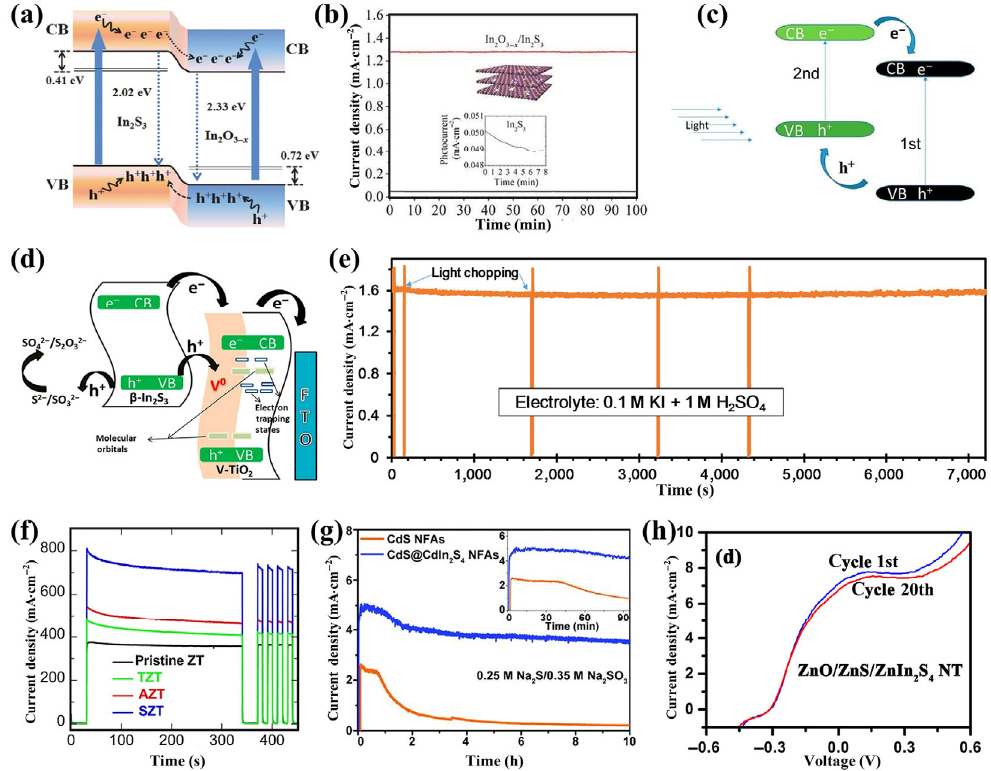
Figure 9 (a) Schematic illustration of the band alignment of the In 2 O 3− x /In 2 S 3 heterostructure. (b) I – T curves of the In 2 S 3 layer and In 2 O 3− x /In 2 S 3 -180s. Reproduced with permission from Ref. [169], © WILEY-VCH Verlag GmbH & Co. KGaA, Weinheim 2017. (c) Schematic diagram of the band structure without internal modifications. (d) Schematic illustration of the charge transfer channel in the V-TiO 2 @β-In 2 S 3 bilayer system. Reproduced with permission from Ref. [158], © American Chemical Society 2016. (e) I – T curves of unoptimized SnS 2 nanoflakes back-illuminated at 0.6 V vs. RHE for 2 h with light chopping (5 times in total). Reproduced with permission from Ref. [175], © WILEY-VCH Verlag GmbH & Co. KGaA, Weinheim 2019. (f) I – T curves of pristine ZT, TZT, AZT, and SZT photoanodes at 0.1 V vs. Ag/AgCl. Reproduced with permission from Ref. [182], © Elsevier B.V. 2015. (g) I – T curves of CdS and CdS@CdIn 2 S 4 NFA at 0 V vs. Ag/AgCl for 10 h. The inset shows the I – T curves for the first 90 min. Reproduced with permission from Ref. [185], © The Royal Society of Chemistry 2017. (h) J – V curve of ZnO/ZnS/ZnIn 2 S 4 after the 1st cycle and after the 15th cycle. Reproduced with permission from Ref. [50], © Elsevier B.V.